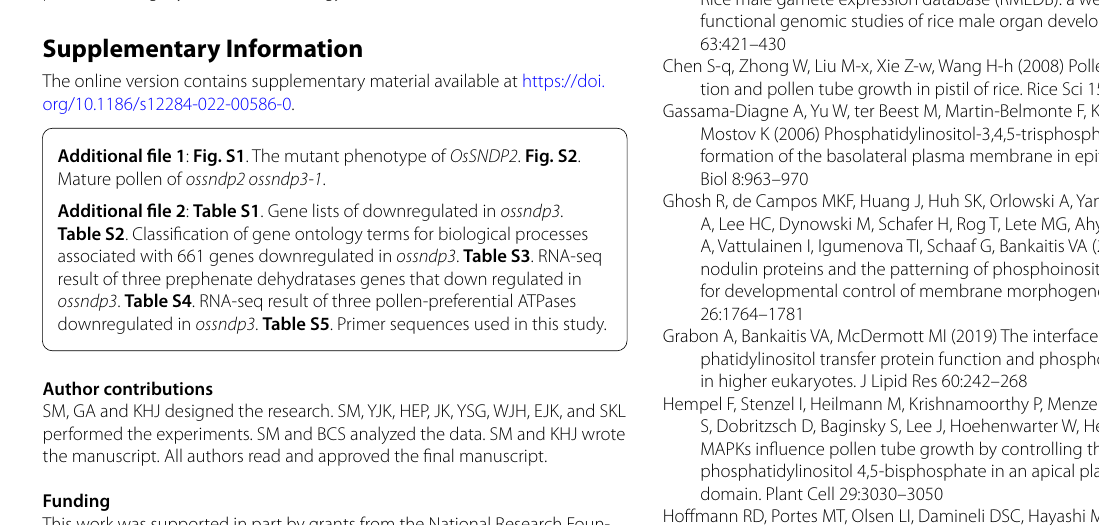
Additional file 2 : Table S1 . Gene lists of downregulated in ossndp3 . Table S2 . Classification of gene ontology terms for biological processes